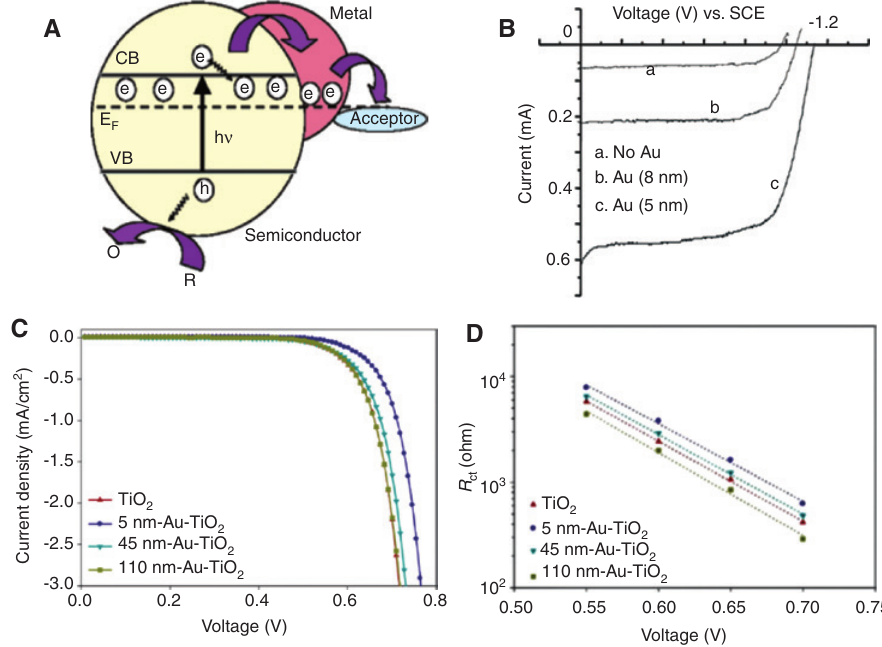
, (b) TiO /Au (8-nm 2 2